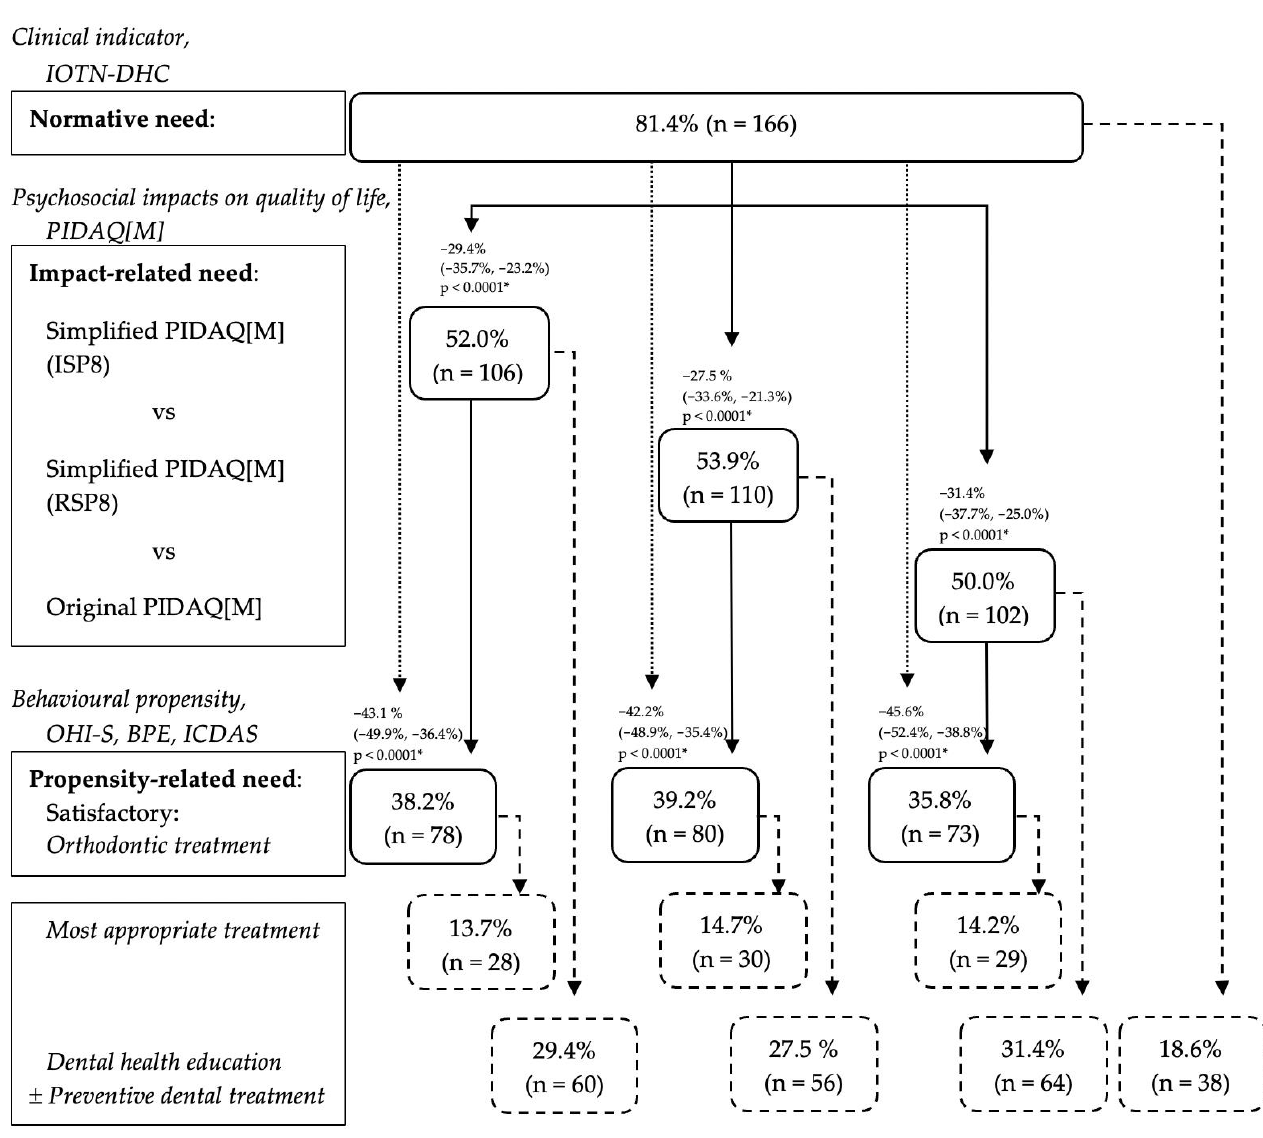
Figure 2. Sociodental approach for assessing orthodontic treatment need comparing the outcomes when either the simplified or the original Malaysian psychosocial impact of dental aesthetics ques- tionnaire (PIDAQ[M]) was used as the impact-related need instrument. Legend: index of orthodontic treatment need, IOTN; simplified oral health index, OHI-S; basic periodontal examination, BPE; index of caries detection and assessment system, ICDAS; no normative need, no impact-related need, or unsatisfactory propensity-related need indicated by a dashed line; * p < 0.05, McNemar test. The difference in the sociodental estimates of orthodontic treatment need when the ISP8 and RSP8 were used in the assessment of impact-related need was not significant ( p > 0.05) (Table